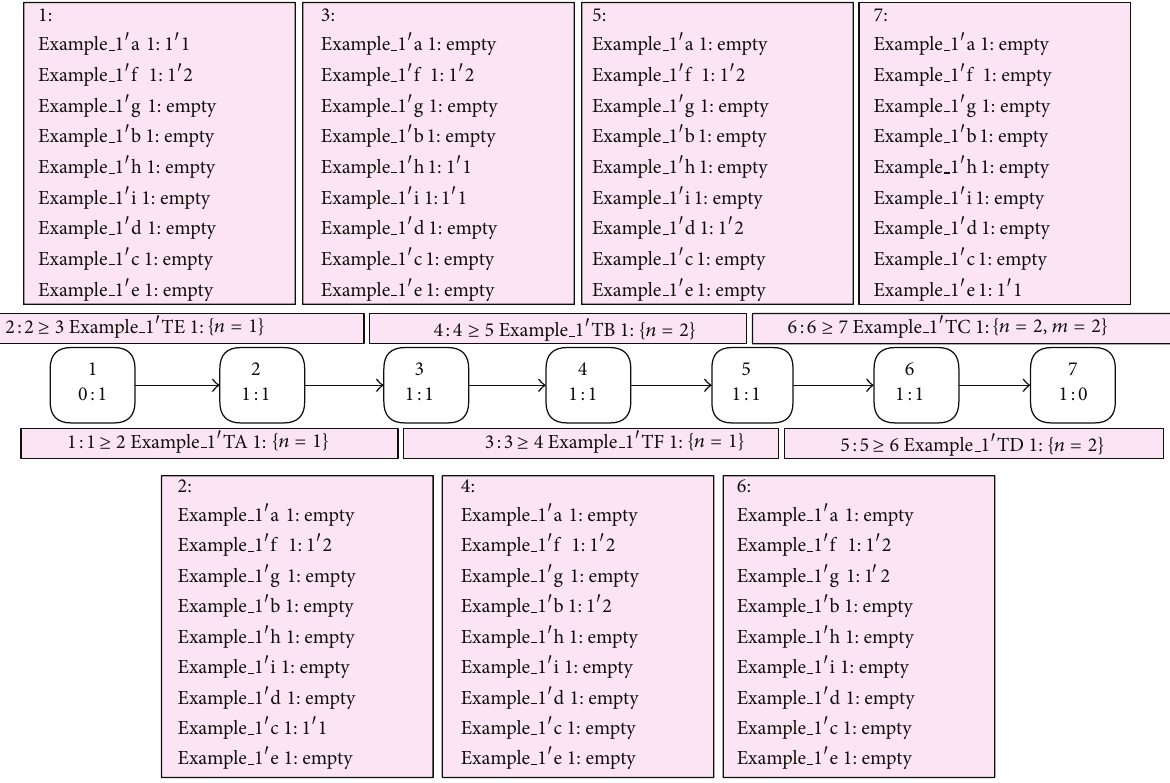
Figure 2: State space of model in Figure